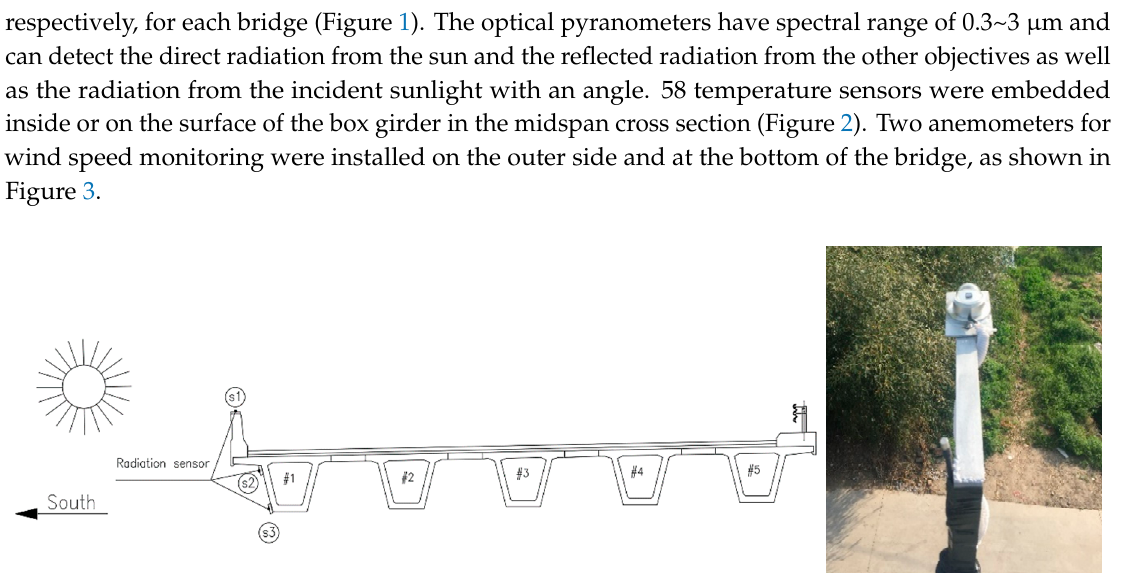
Figure 1. Radiation sensor (optical pyranometer) positions at the midspan.